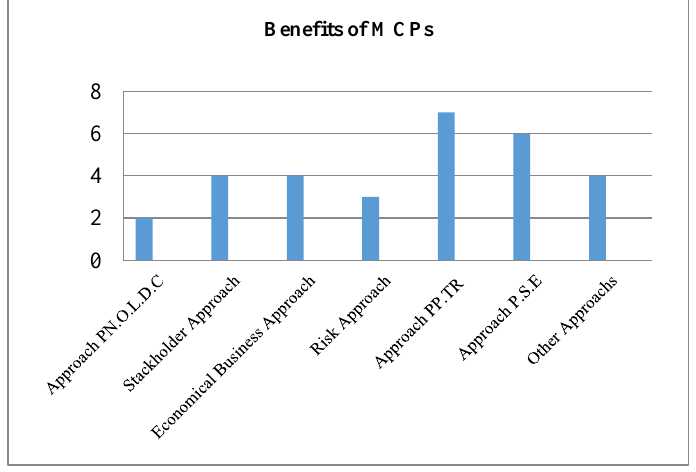
Figure 11. Degree of agreement among authors about the benefits of MCPs depends on previous approaches. “Source: